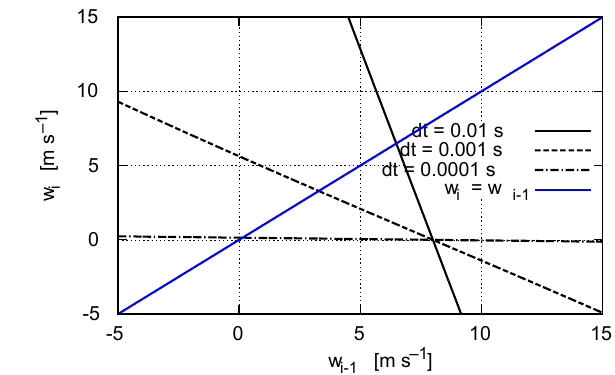
Figure 8. Downwash after an iteration as a function of the down- wash from the preceding iteration in the case of a single section with trailed